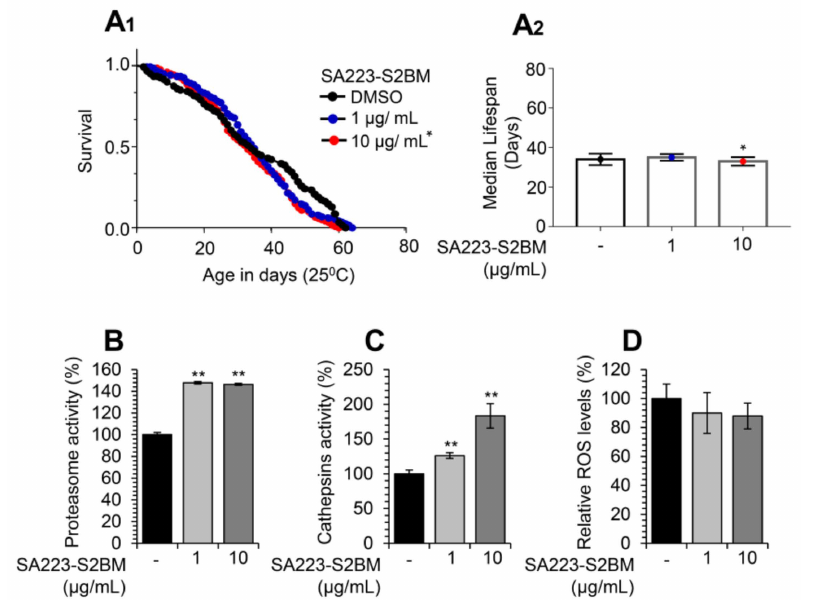
Figure 4. Treatment of Drosophila flies with the extract SA223-S2BM activates cell proteostatic modules. ( A 1 , A 2 ) Representative longevity curves ( A 1 ) and median lifespan ( A 2 ) of young w 1118 flies fed with either normal culture medium (DMSO) or with medium supplemented with 1 or 10 µ g/mL of the SA223-S2BM extract; comparative statistics are reported in detail in Table S1. ( B ) Relative (%) chymotrypsin-like proteasome peptidase activity in somatic tissues of young (10–13 days of age) w 1118 flies treated with the indicated concentrations of the SA223-S2BM extract for 10 days. ( C ) Relative (%) cathepsins activity in somatic tissues of young (10–13 days of age) w 1118 flies treated with the shown concentrations of the extract for 10 days. ( D ) Relative (%) ROS levels in somatic tissues of young (10–13 days of age) w 1118 flies treated with the shown concentrations of the extract for 10 days. In ( B – D ) control samples values were set to 100%; bars, ± SD ( n ≥ 2); * p < 0.05; ** p <